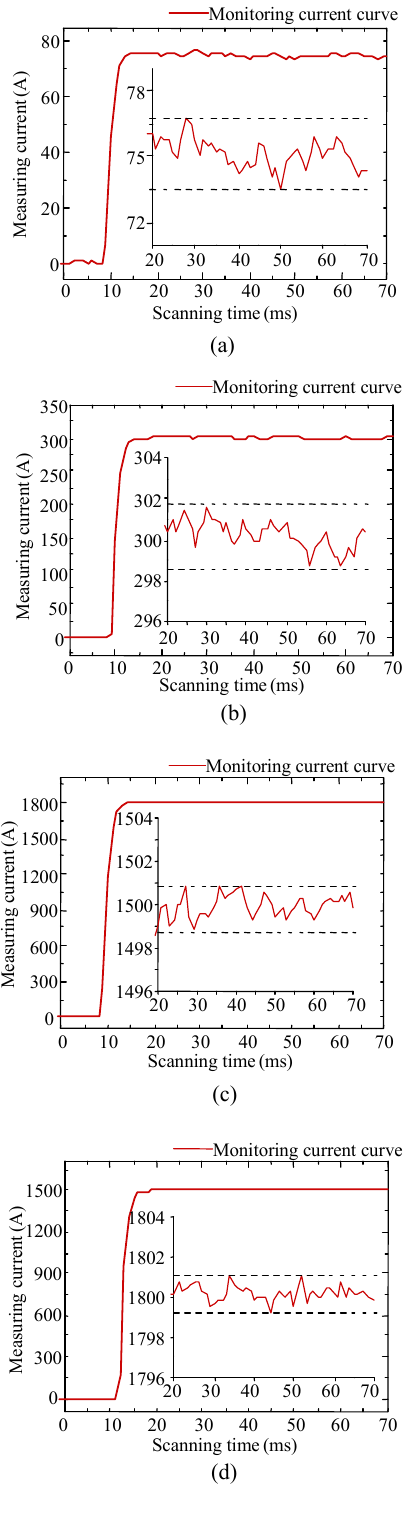
Fig. 5 Current variation diagram of the prototype: (a) the primary current is 75 A, (b) the primary current is 300 A, (c) the primary current is 1500 A, and (d) the primary current is 1800 A.